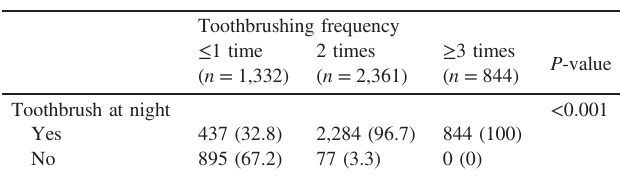
Table 2. Association between toothbrushing frequency and toothbrushing at night